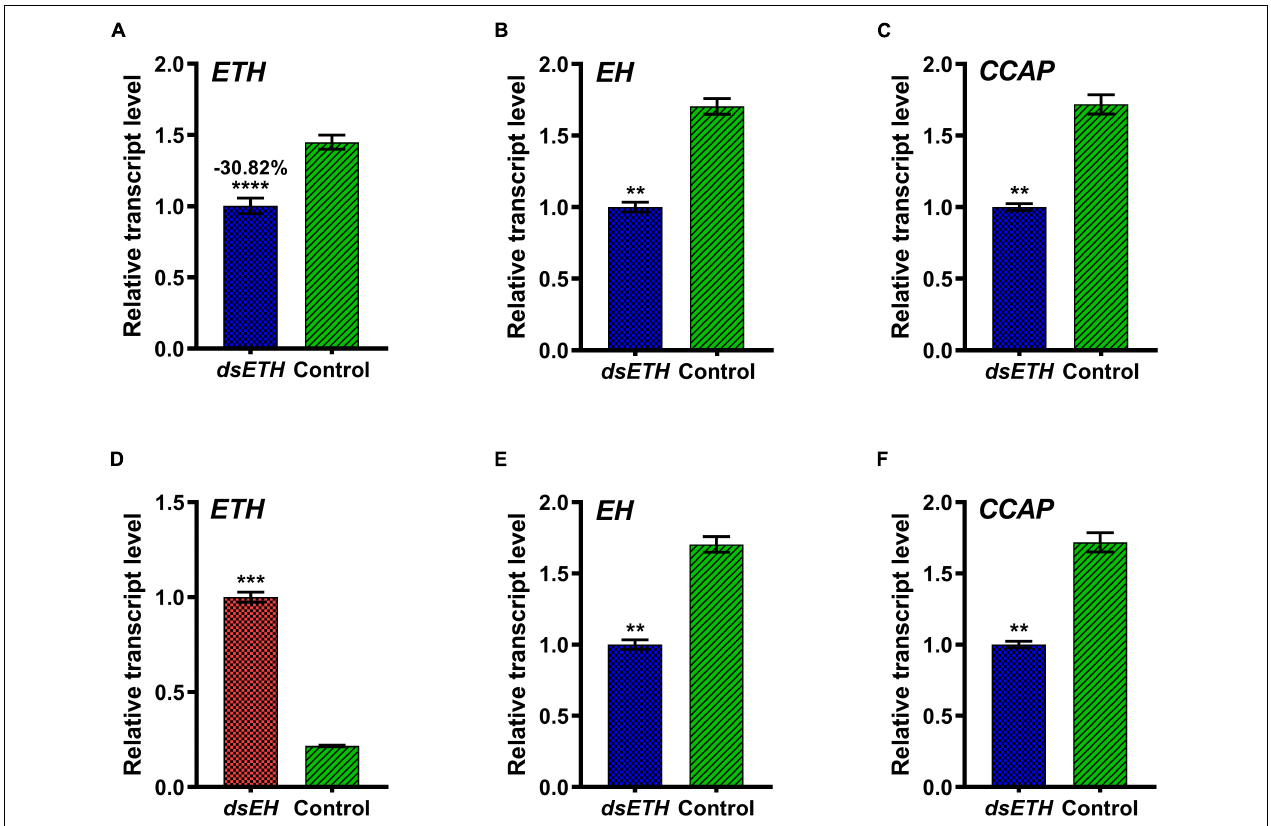
FIGURE 4 | Relative transcript levels of ETH (A) , EH (B) , and CCAP (C) in thoracic ganglia of dsGFP and dsETH -injected crabs at D0 stage were measured. Also, relative transcript levels of ETH (D) , EH (E) , and CCAP (F) in the thoracic ganglia of dsGFP and dsEH -injected crabs at the D0 stage were measured. These data represented the mean ± SD. For each sample, three independent pools of five individuals were measured in technical triplicate using real-time quantitative PCR (qRT-PCR). Statistically significant differences between the measurements were found via a t -test with Welch’s correction and are indicated by asterisks (** P < 0.01; *** P < 0.001; **** P <